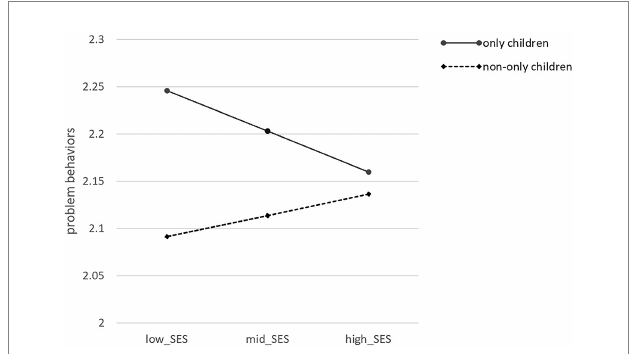
FIGURE 3 Conditional Effects of the Focal Predictor (SES) at Values of the Moderator as only child number. N = 1,101. Mean change is displayed separately for only children and non-only